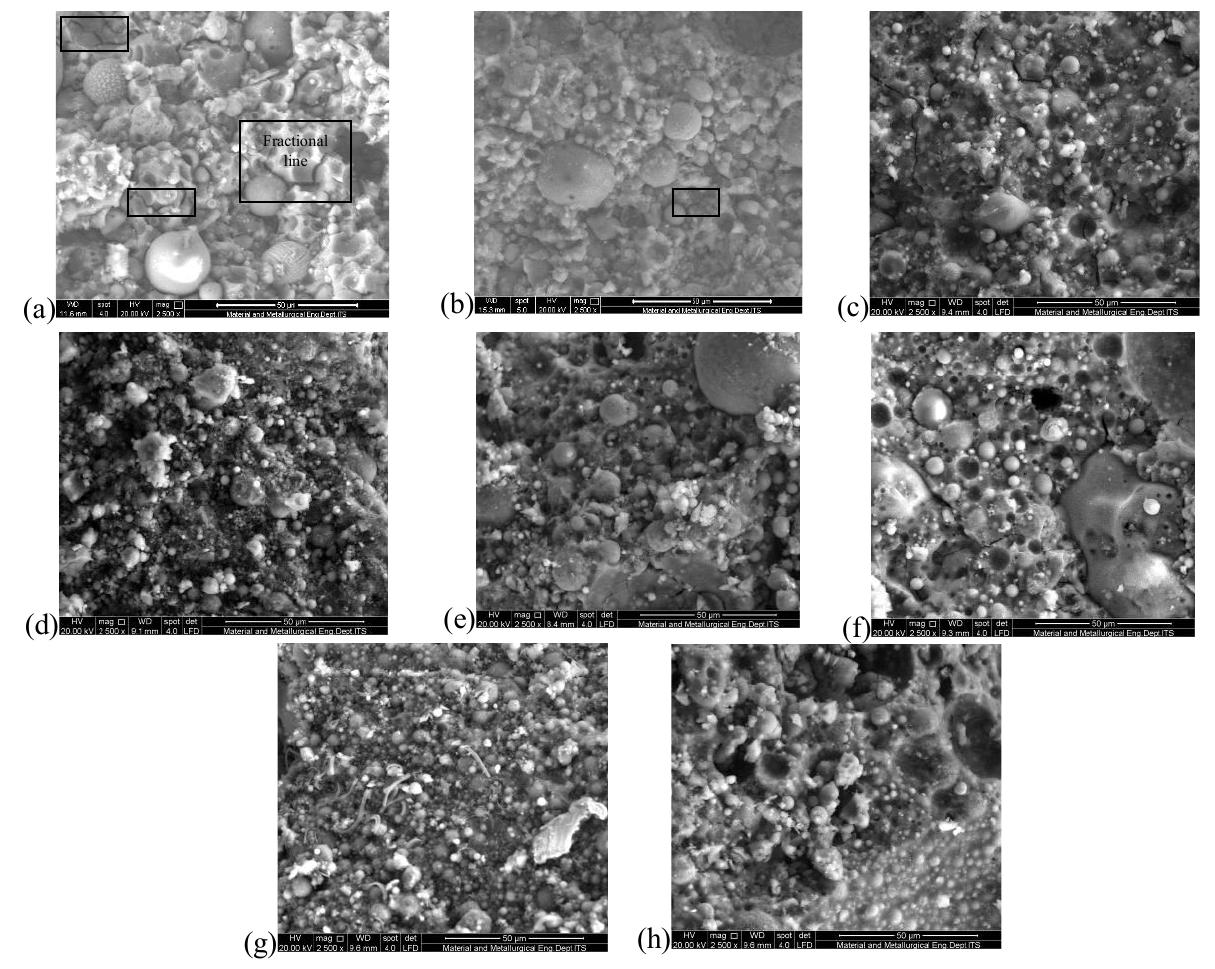
Figure 3: SEM of geopolymer sample for (a) surface geopolymer without pore-forming agent addition, (b) cross section of geopolymer -